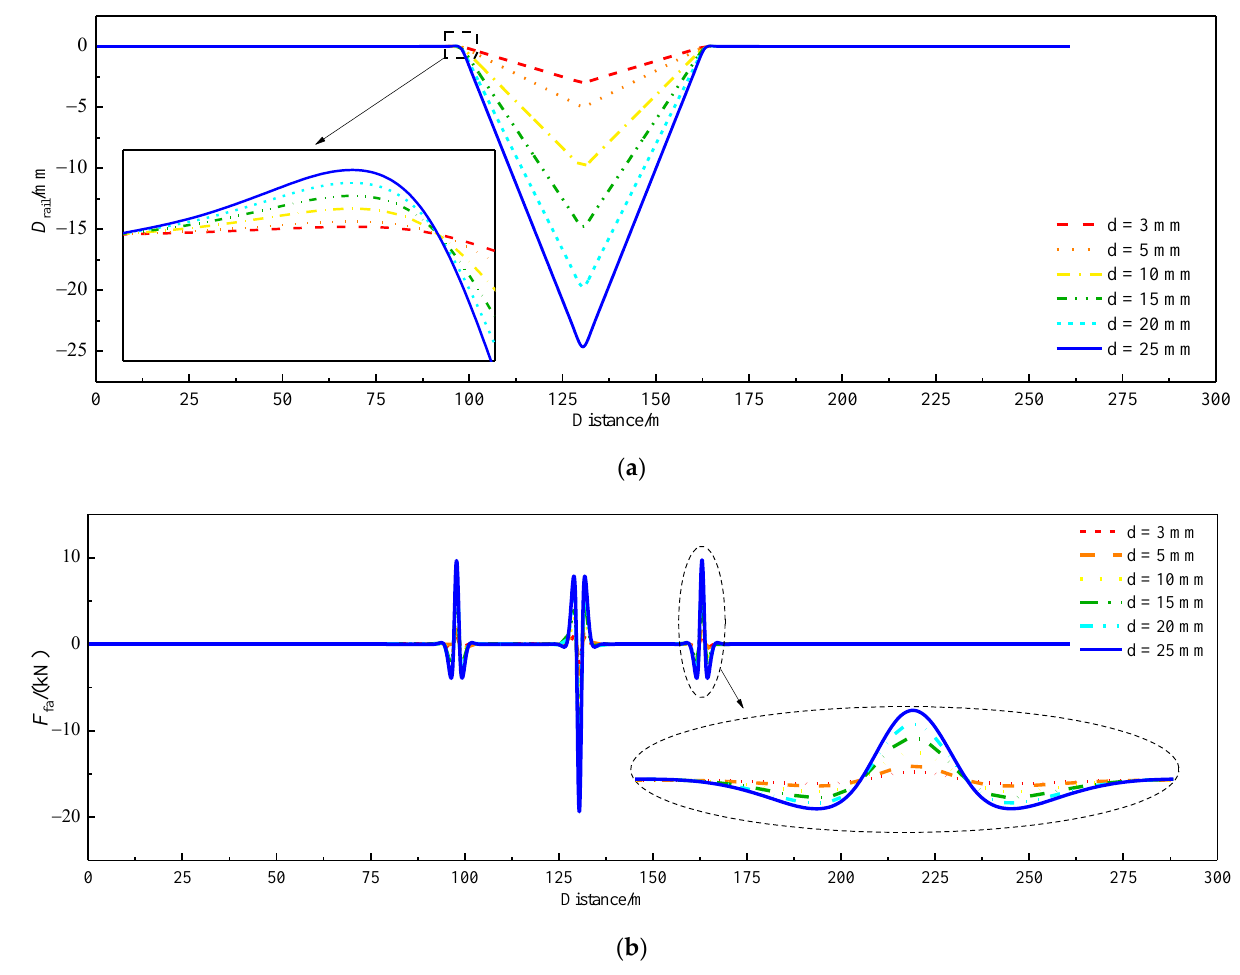
Figure 9. The influence of pier settlement amplitudes. ( a ) Mapping deformation of the rail under different pier settlements. ( b ) Fastener force under different pier settlements.